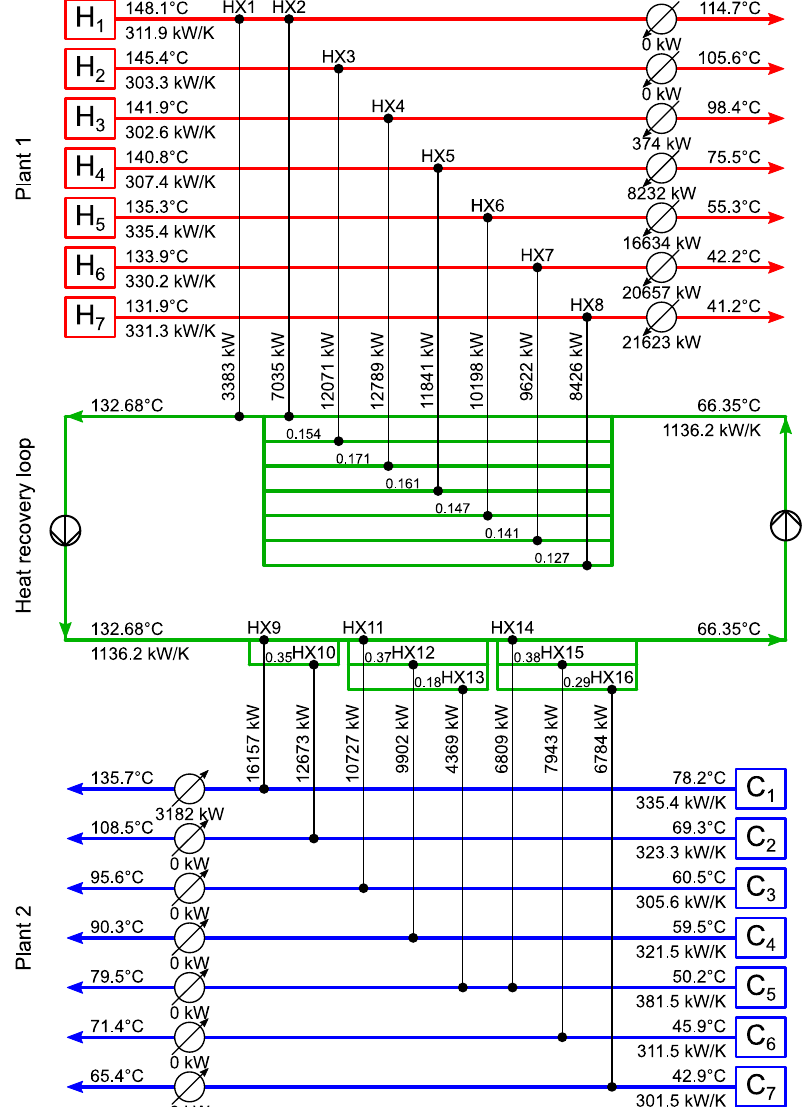
Figure 6. Plant representation of the optimal HEN configuration found of example 2 including a HRL (TAC: 1.54 M$/yr).